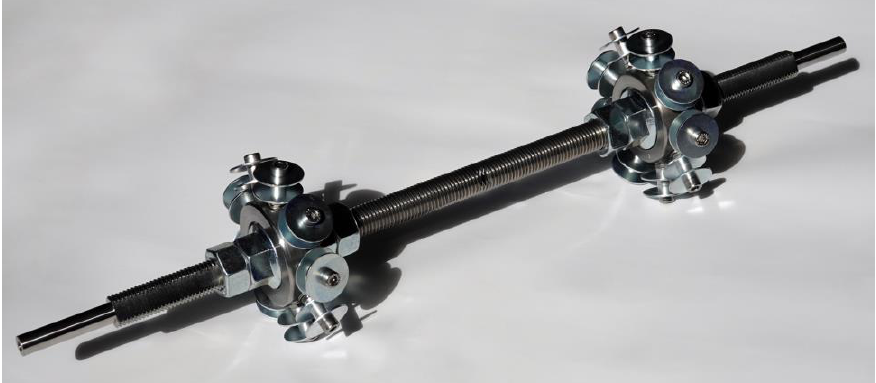
Figure 8. Winding fixture for the generic cylindrical samples equipped with medium size winding pins.